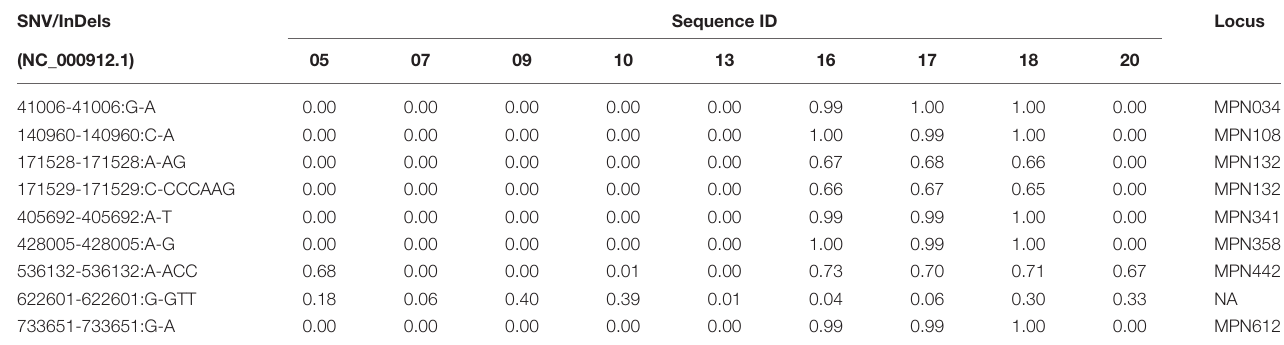
Lower RTI group